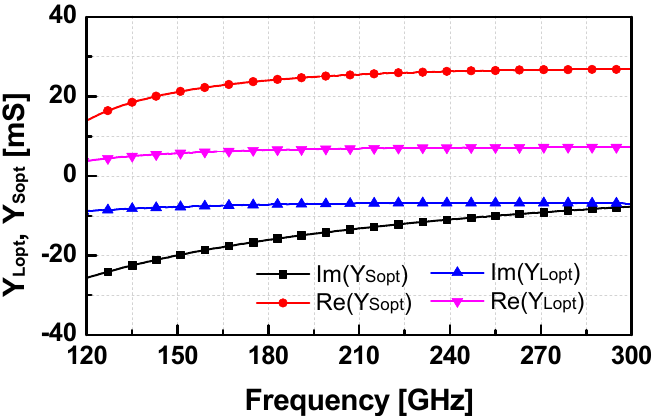
Figure 5. Optimum load and source admittances of post-layout RC-extracted HBT (2 × 70 nm × 900 nm) for the gain matching.